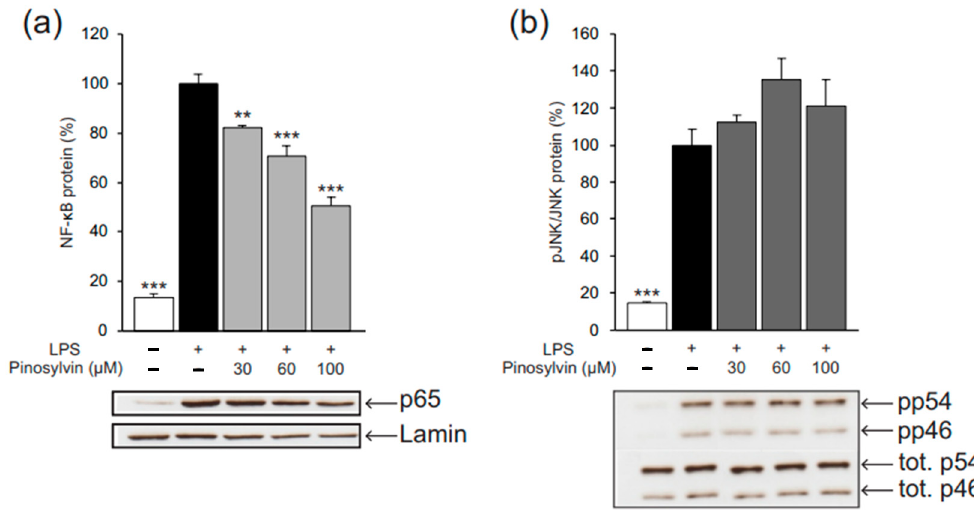
Figure 7. Pinosylvin inhibited lipopolysaccharide (LPS)-stimulated activation of nuclear factor kappa B (NF- κ B, a ), but had no effect on the phosphorylation (i.e., activation) of C-Jun N-terminal kinase (JNK, b ) in J774 murine macrophages. J774 cells were cultured with LPS (10 ng/mL) alone, or together with pinosylvin for 30 min ( a ); in ( b ) the cells were first preincubated with pinosylvin for 30 min and then stimulated with LPS (10 ng/mL) for one hour. The p65 subunit of NF- κ B in the nuclear extract and phosphorylated JNK in the total cell lysate were measured with Western blot. The p65 subunit of NF- κ B was normalized against lamin, and the phosphorylated JNK against total JNK. The results are expressed as mean + SEM, n = 4. Statistical significance of the results was calculated by one-way ANOVA followed by Bonferroni multiple comparisons test. ** = p < 0.01 and *** = p < 0.001 as compared to cells cultured with LPS only, marked as a black bar.